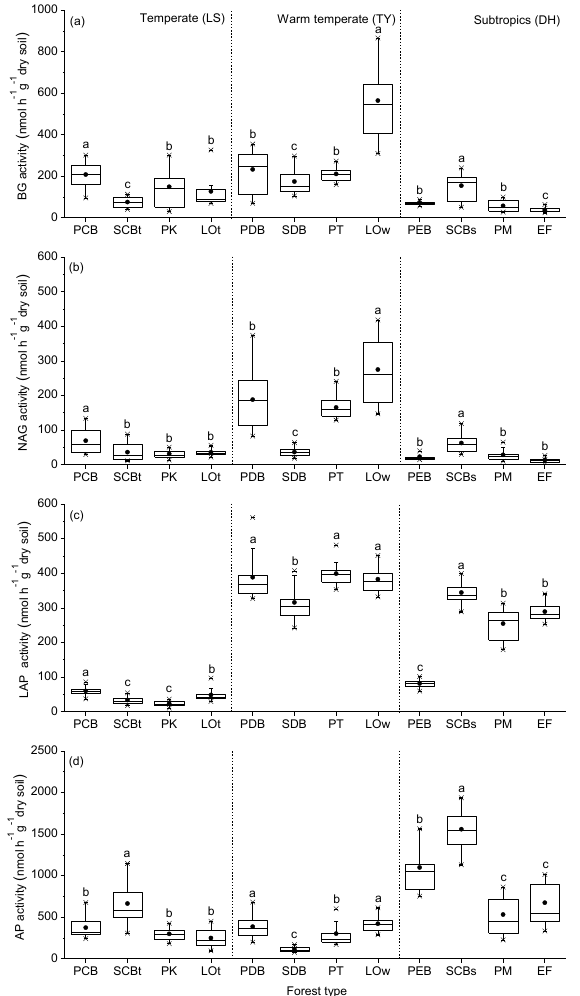
EF05001000150020002500 PCB SCBt PK LOt PDB SDB PT LOw PEB SCBs PM Figure 1. Soil enzyme activities under different forest types in different climatic zones. BG, b-1, 4-glucosidase; NAG, b-1,4- N-acetylglucosaminidase; LAP, leucine aminopeptidase; AP, acid phosphatase. Panels (a) , (b) , (c) , and (d) represent the variations in the enzyme activities of BG, NAG, LAP, and AP, respectively. Different lowercase letters indicate significant differences between forests in the same climatic zone. The abbreviations of the sampling sites are shown in Table